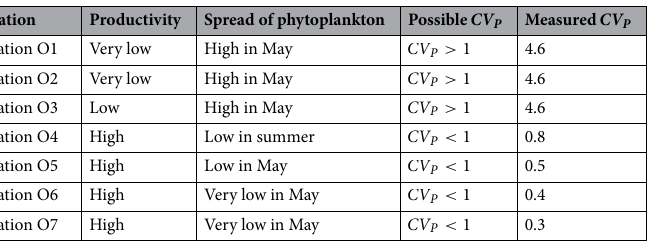
Table 8. Comparison of model predicted CV P values with measured experimental CV P values at different